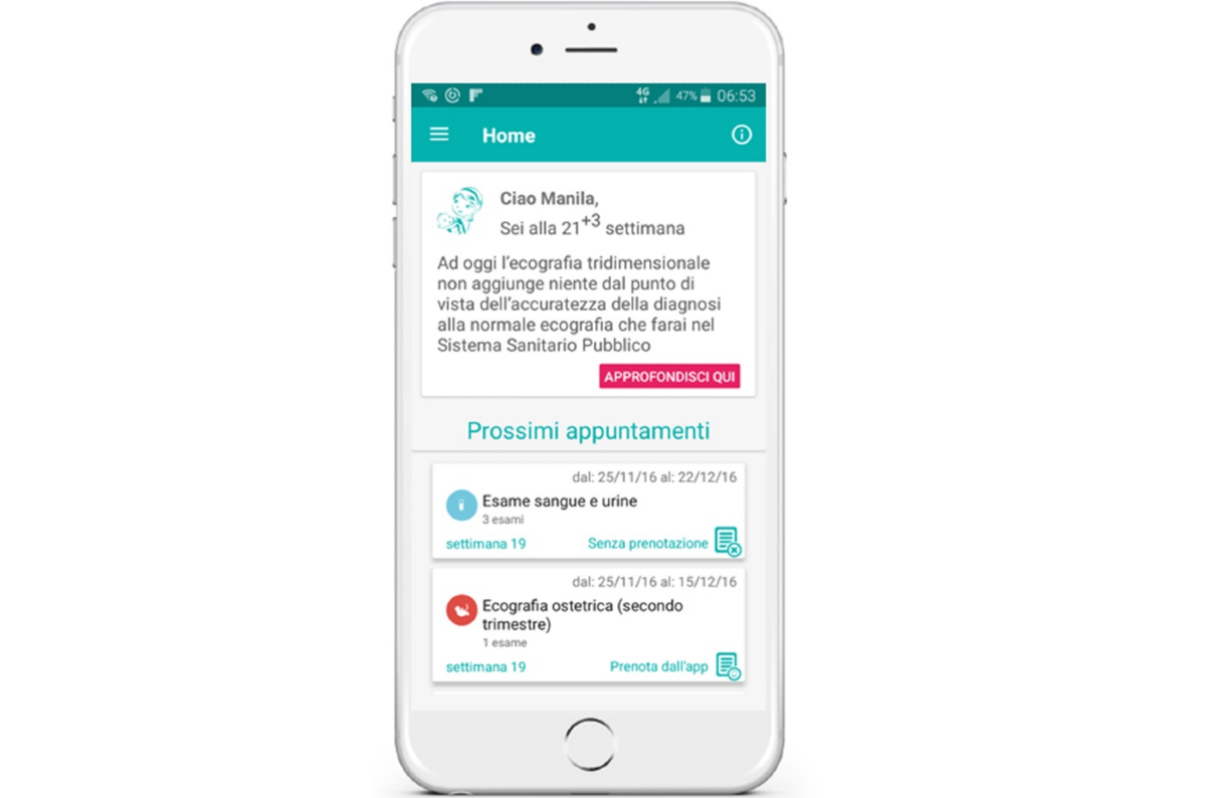
Figure 1. hAPPyMamma home page: identification of gestational age (during pregnancy) or newborn age (in the postpartum period), specific week-by-week messages, and memos for upcoming appointments.